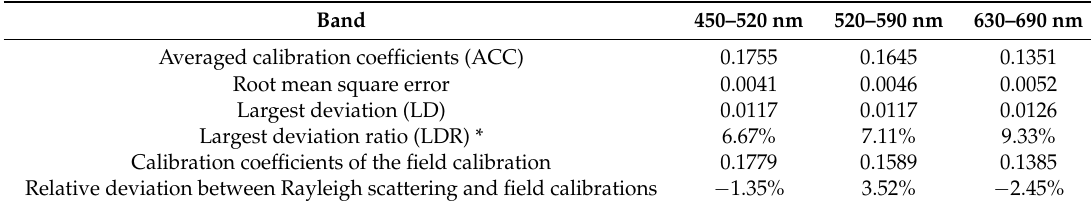
Figure 5. Absolute radiometric calibration coefficients (A i ) of 22 samples computed by the Rayleigh scattering method versus solar zenith angle at wavelengths of 450–520 nm (blue), 520–570 nm (green), and 630–690 nm (red). The mean coefficients for the 3 bands are 0.1755, 0.1645, and 0.1351, respectively. Table 3. The assessment for the Rayleigh scattering calibration of GF-1/WFV3 and the comparison with the Dun Huang field calibration.